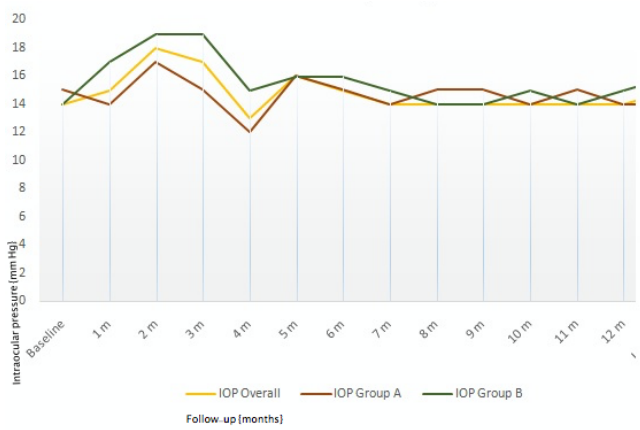
Figure 6: Mean monthly changes in IOP among study eyes